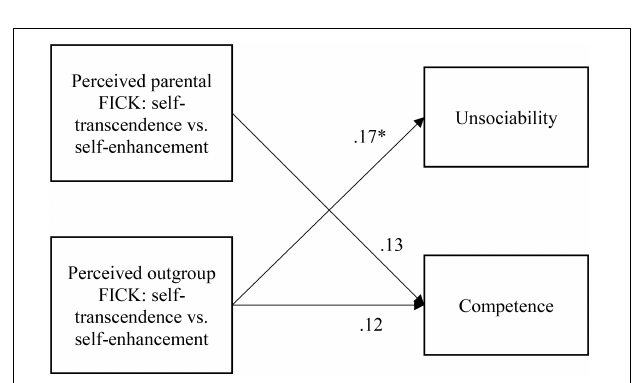
FIGURE 4 | The path model depicting how perceived parental and outgroup FICK in self-transcendence versus self-enhancement affect competence and unsociability auto-stereotypes (Study 2). FICK, fit in cultural knowledge. Numbers represent standardized regression coefficients. ∗ p <